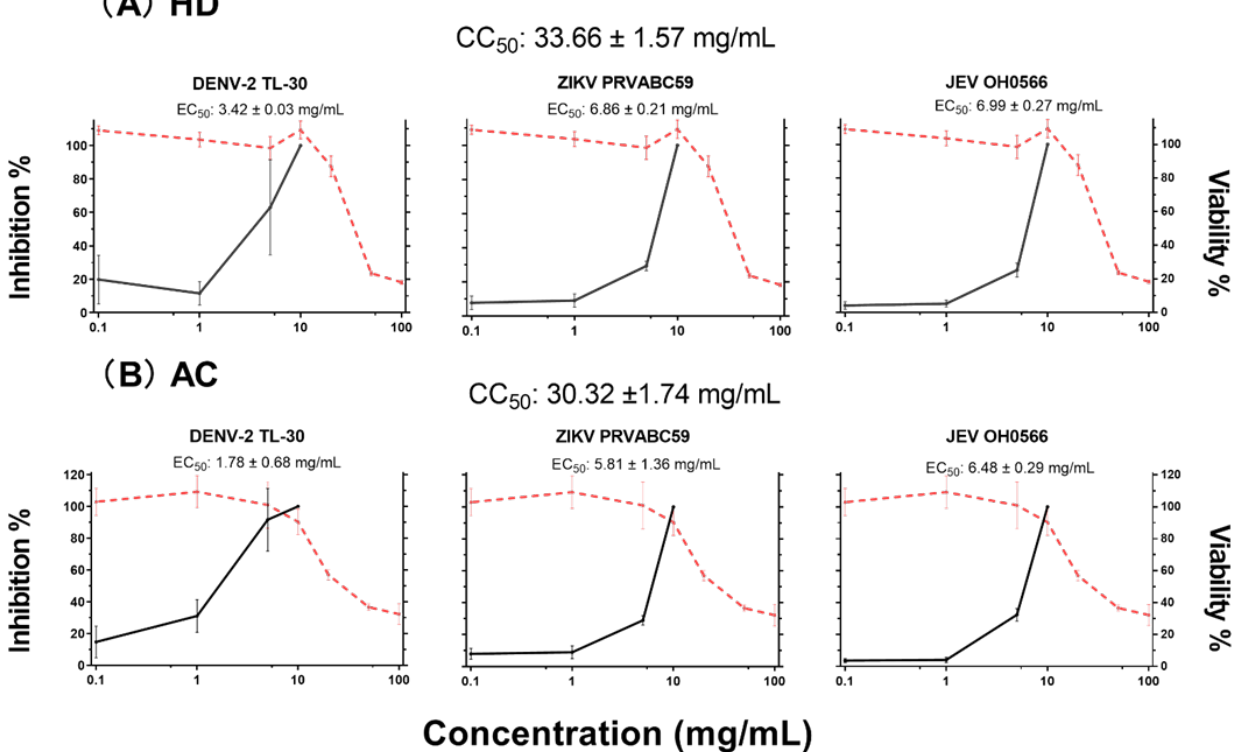
Figure 1. Herb extract cytotoxicity and dose–response relationships of antiviral efficacy. (1) Cytotoxicity (red lines): Vero 9013 cells were seeded at a density of 2 × 10 4 cells/well and cultured for 24 h. Cells were overlaid with media containing various concentrations of each herb and cultured an additional 4 days. MTT cell proliferation and cytotoxicity assay was used to determine cell viability, which was normalized for CC 50 determination. (2) Dose–response relationships of antiviral efficacy (black lines): Vero 9013 cells were incubated with each virus at MOI 0.01 for 1 h, and unbound virus was removed by washing with EMEM to synchronize the replication, then treated with each herb at a range of concentrations (10, 5, 1, and 0.1 mg/mL). Supernatants were collected to determine infectious viral titers at 72 h p.i. for JEV OH0566 and ZIKV PRVABC59 and 96 h p.i. for DENV-2 TL-30, respectively. Inhibition (%) = (viral titer (log 10 PFU/mL) of treated culture supernatants / mean viral titer (log 10 PFU/mL) of untreated viral-infected control culture supernatants ) × 100%. The value of inhibition (%) was normalized for EC 50 determination. The error bars represented the standard deviation of the mean of duodecuplicate (12 copies). (A) Cytotoxicity and viral titer analysis for which treatment with Hedyotis diffusa (HD). (B) Cytotoxicity and inhibition in Artemisia capillaris .(AC) treated samples.